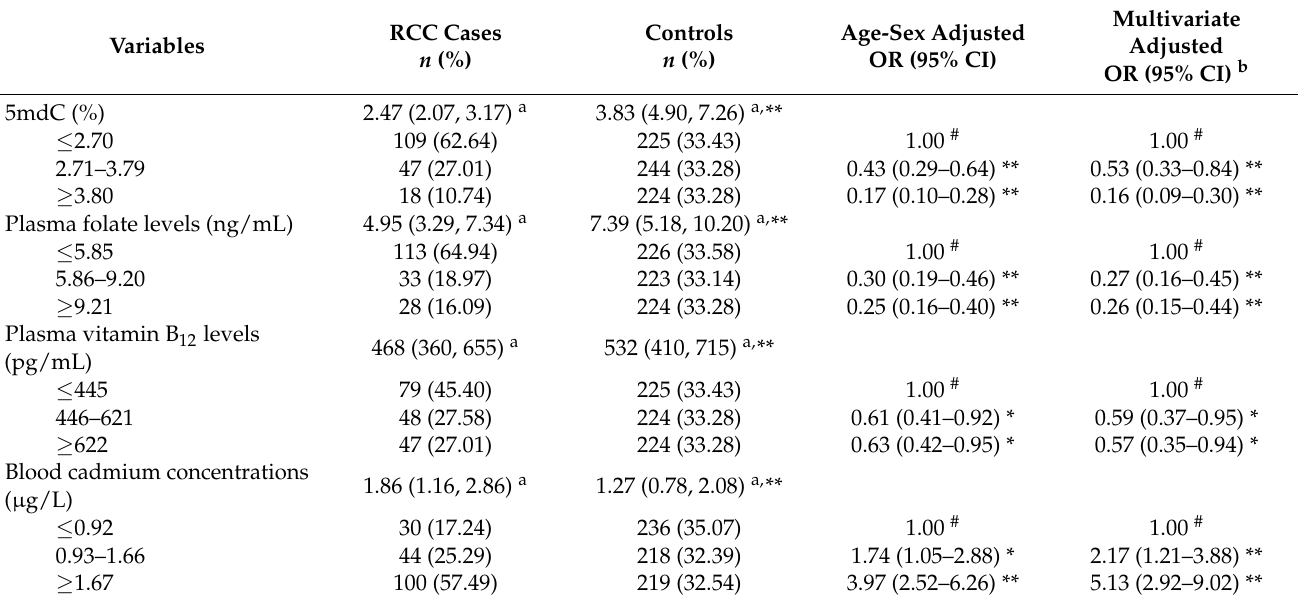
Table 2. Associations of 5mdC (%), plasma folate and vitamin B 12 levels, and blood cadmium concentrations with